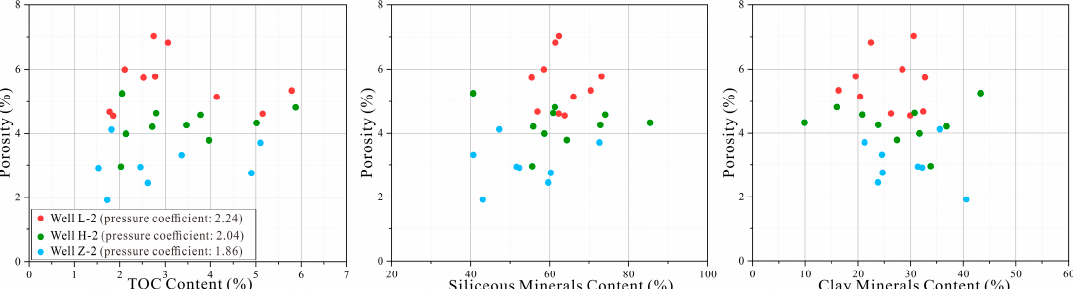
Figure 9. A comparison of the total porosity of shale reservoirs with similar material composition and different pressure coefficients illustrates that the L-2 shale reservoir with a pressure coefficient of 2.24 has a relatively higher total porosity, and the Z-2 shale reservoir with a pressure coefficient of 1.86 has relatively lower total porosity.